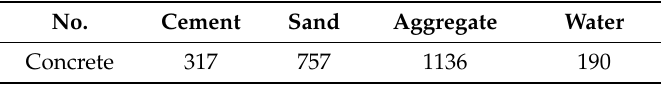
Table 1. Mix proportion of the old concrete (kg / m3).